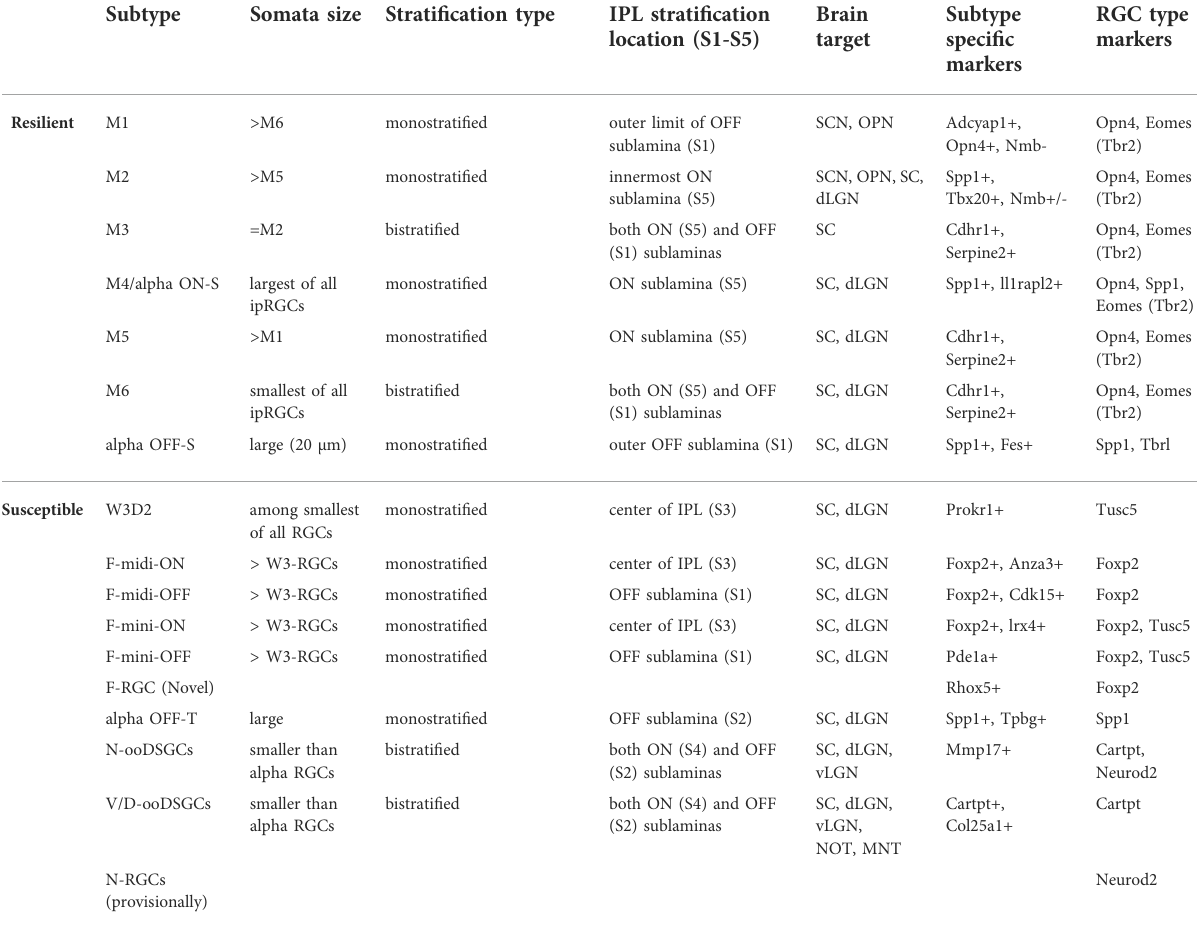
TABLE 1 Summary of characteristic features found in resilient and susceptible RGC